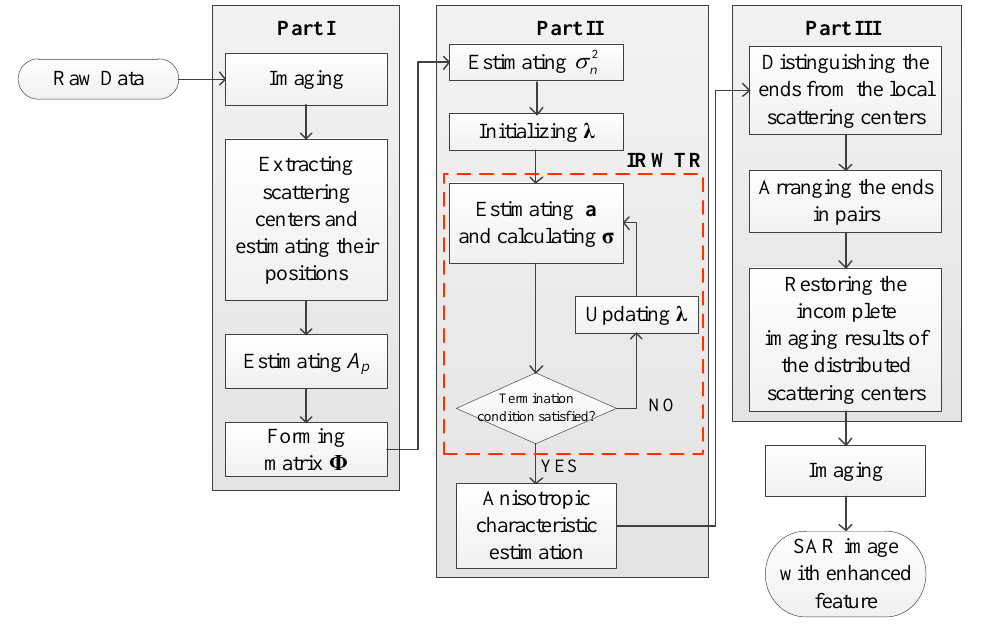
Figure 6. Flowchart of the proposed method.